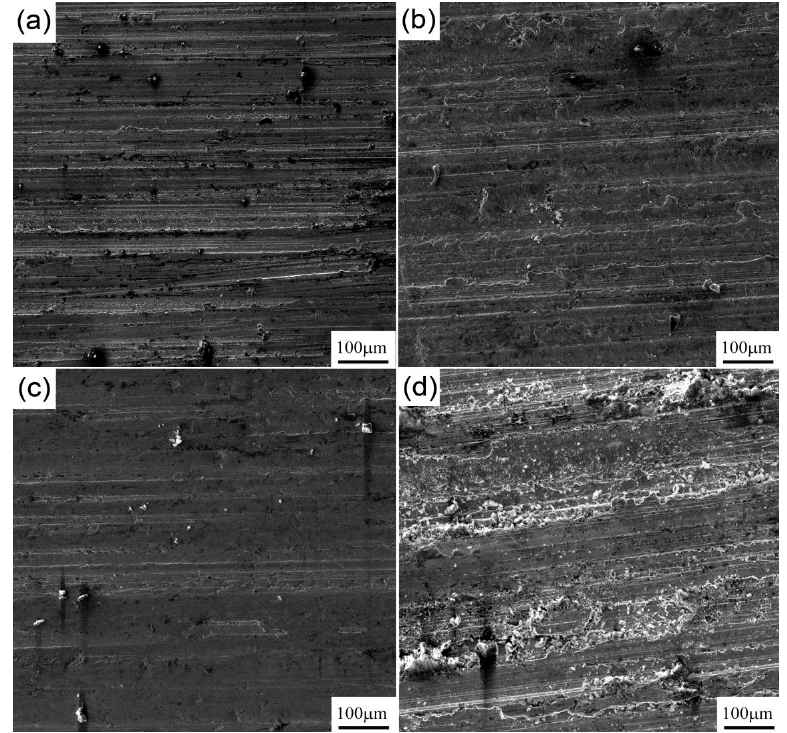
Figure 8. Worn morphology of various hardfacing layers: ( a ) 1.71% B; ( b ) 3.42% B; ( c ) 5.10% B; ( d ) 6.85% B.